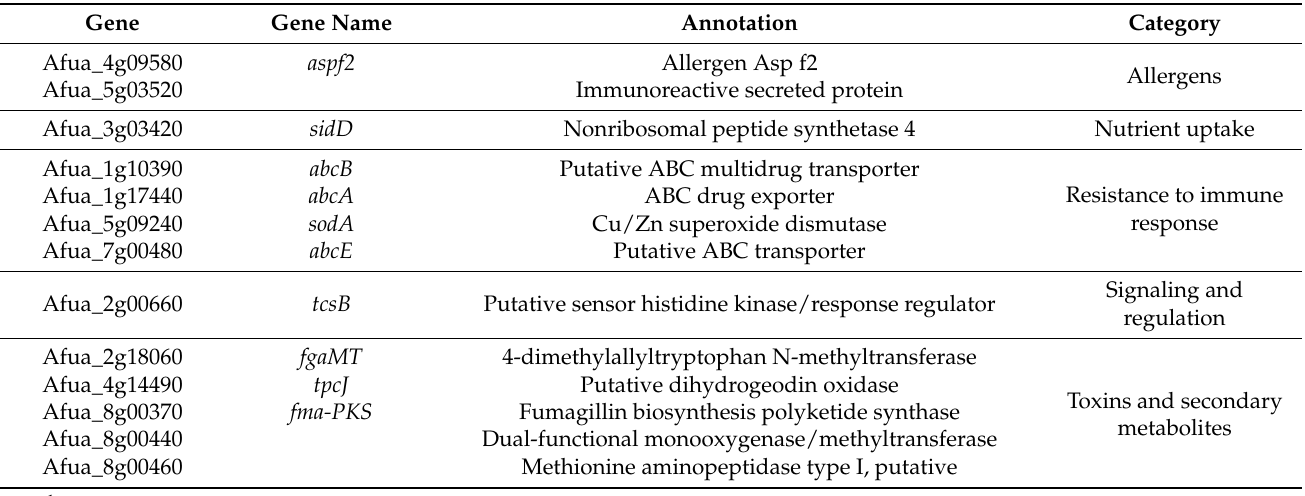
Table 1. Positive selection in A. fumigatus virulence genes 1